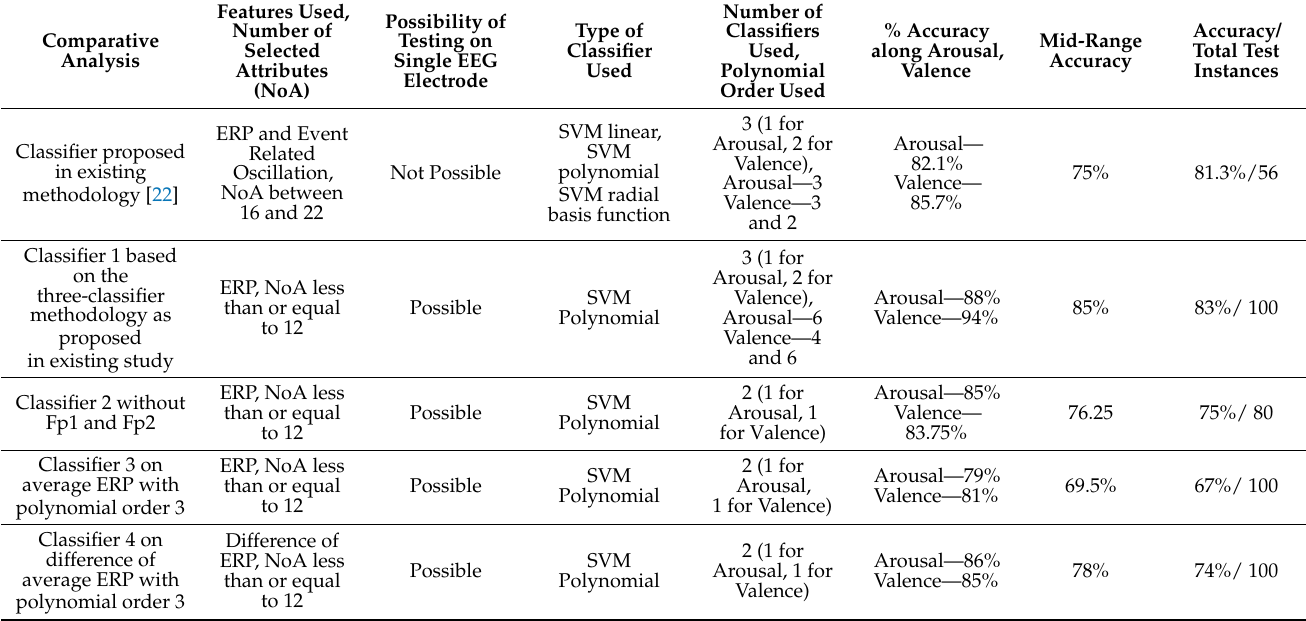
Table 12. Comparative analysis of results with already existing study on